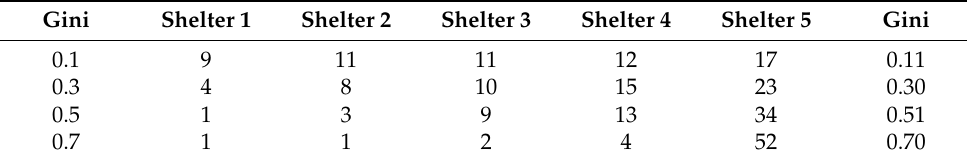
Table A4. Inputs for the simulation when the total demand is 60.